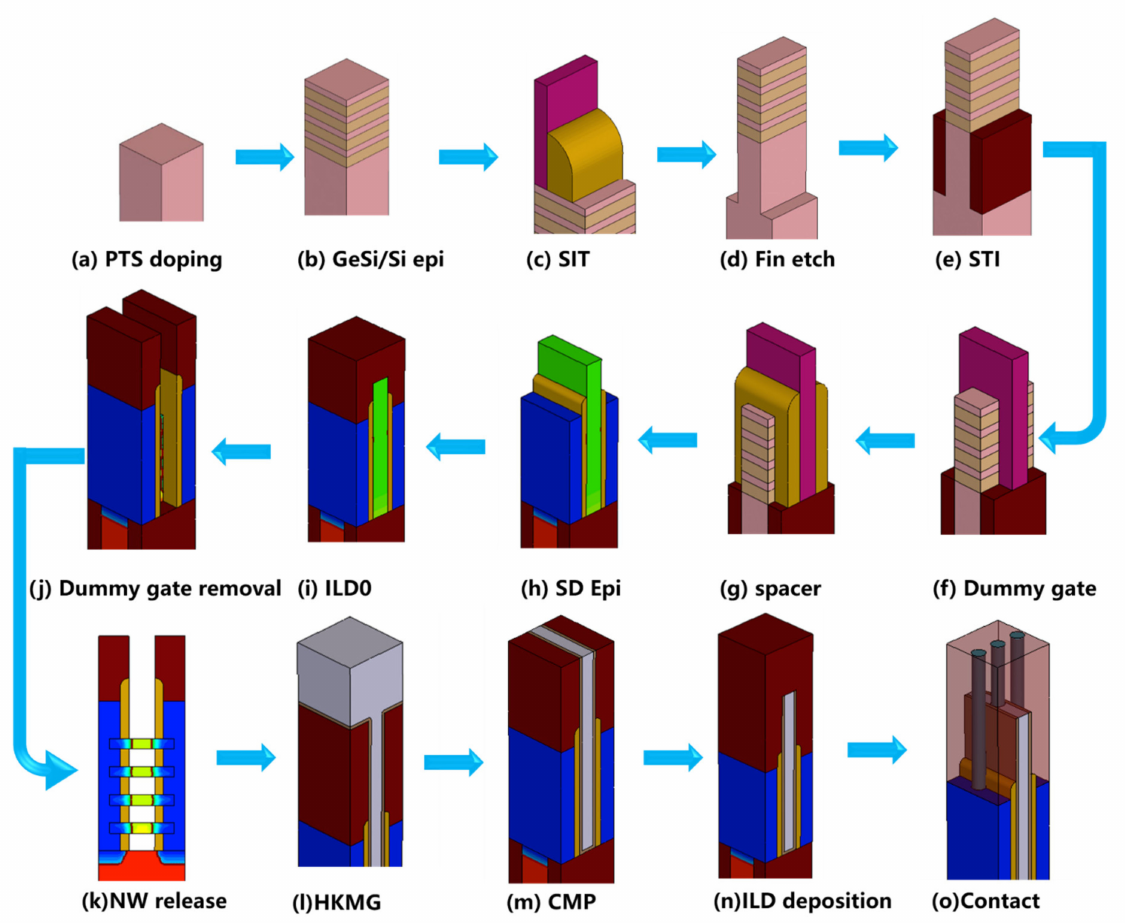
Figure 1. Fabrication flow of stacked gate-all-around Si nanosheet metal-oxide-semiconductor field effect transistors (GAA Si NS MOSFET): ( a ) 200 mm p -type (100) silicon wafers after ground-plane (GP) doping, ( b ) epitaxy of multi-layer GeSi/Si stacks, ( c ) the pattern of fin arrays formed by a spacer image transfer (SIT), ( d ) fin etch, ( e ) shallow trench isolation (STI) formation, ( f ) dummy gate formation, ( g ) Si 3 N 4 spacers formation, ( h ) epitaxy of source drain (SD), ( i ) ILD0 deposition, ( j ) dummy gate removal, ( k ) Si NS channels release, ( l ) high-k dielectric/metal gate (HK/MG) formation, ( m ) chemical mechanical planarization (CMP), ( n ) ILD deposition, and ( o ) contact and